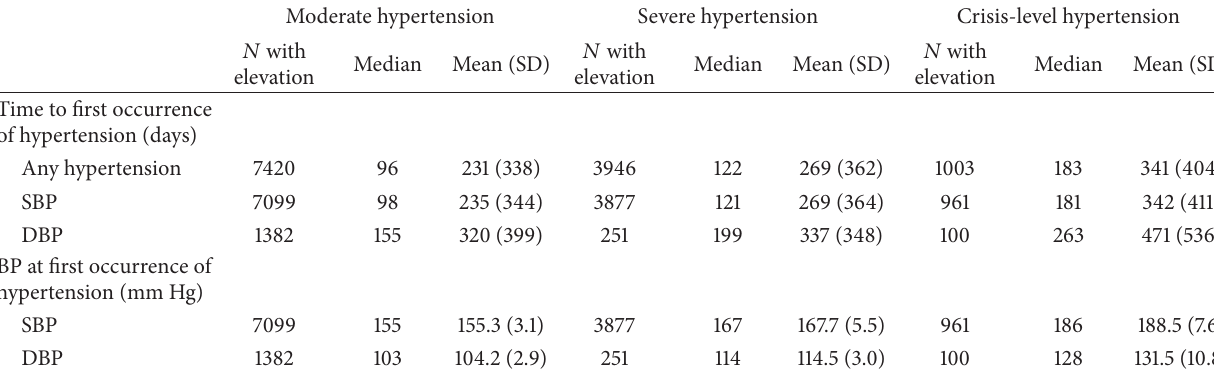
Table 3: Time to first occurrence of